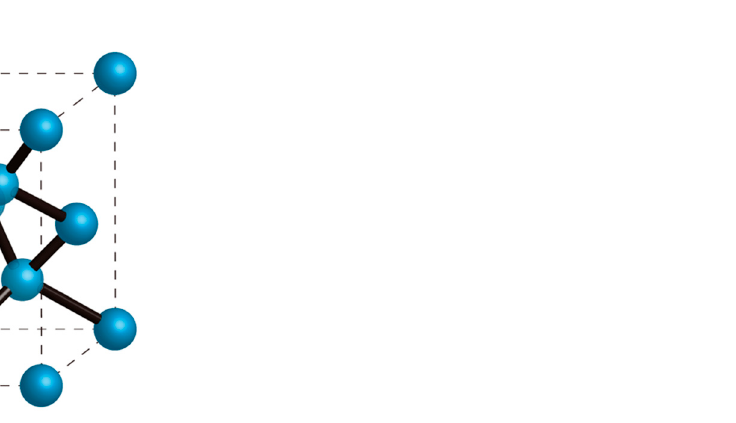
Figure 1. A schematic illustration of a NV center in diamond lattice consists of a substitutional nitrogen atom (red), an atomic vacancy (white) and carbon atoms (blue).